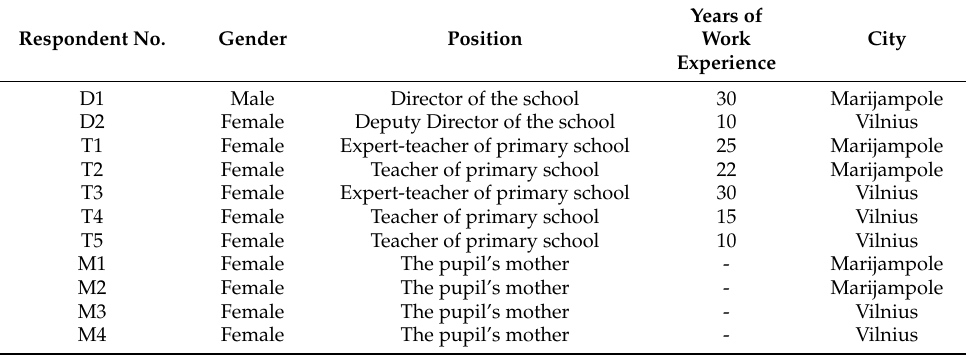
Table 2. Sociodemographic characteristics of respondents.